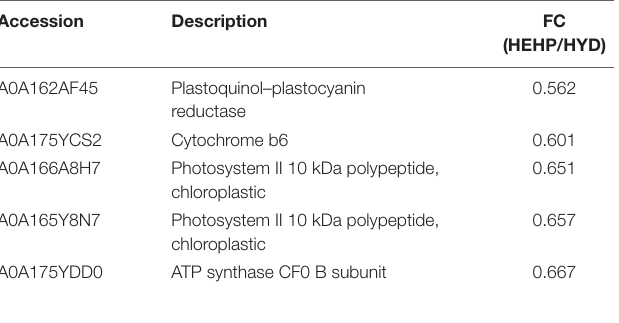
TABLE 5 | Downregulated DAPs involved in photosynthesis (pathway ID: map00195) in HEHP vs.